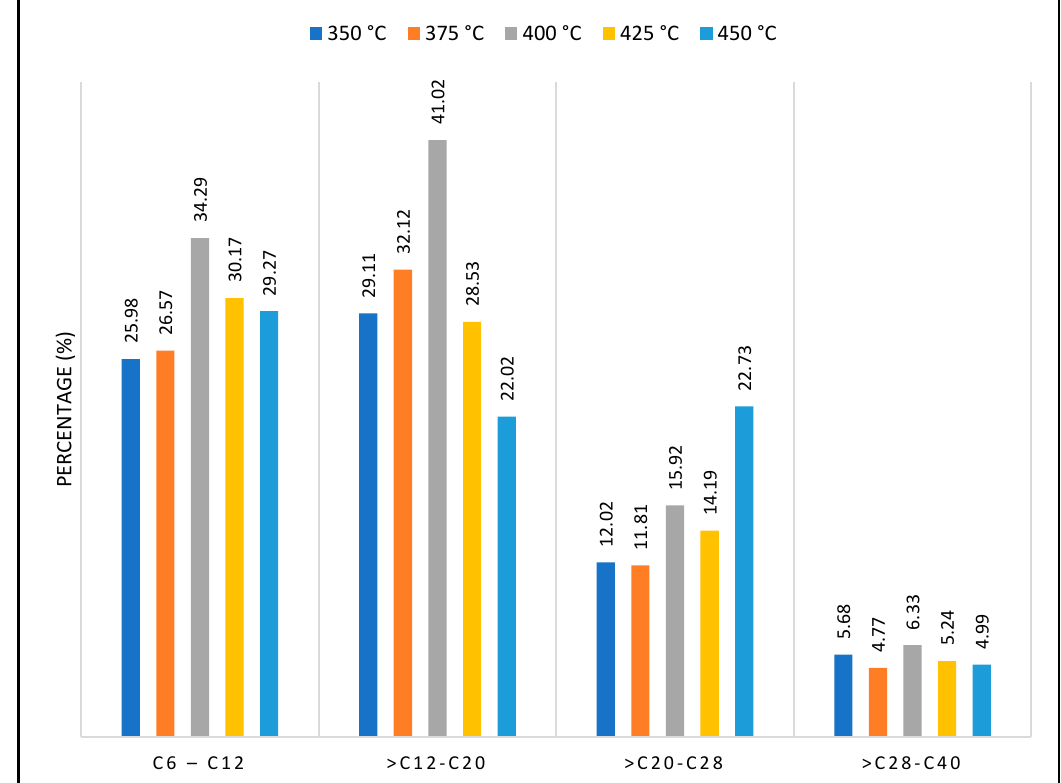
Figure 5. Distribution of the liquid fraction composition after 10 min of reaction.